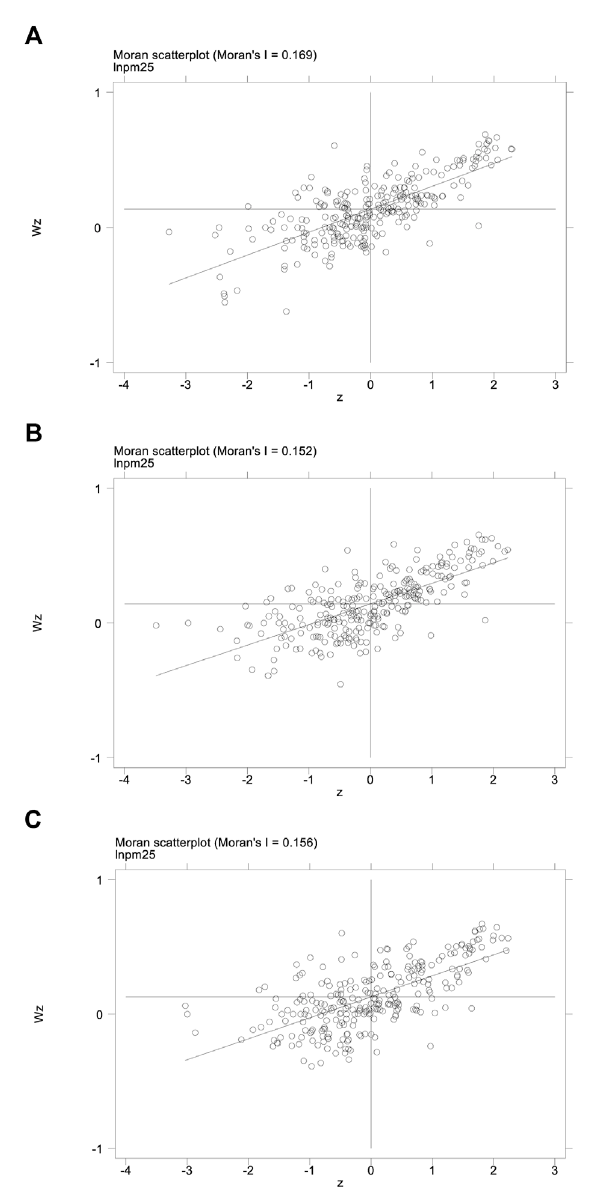
Moran scatterplot of urban PM 2.5 concentration. (A) denotes the Moran scatterplot in 2006, (B) denotes the Moran scatterplot in 2011, and (C) denotes the Moran scatterplot in 2017.